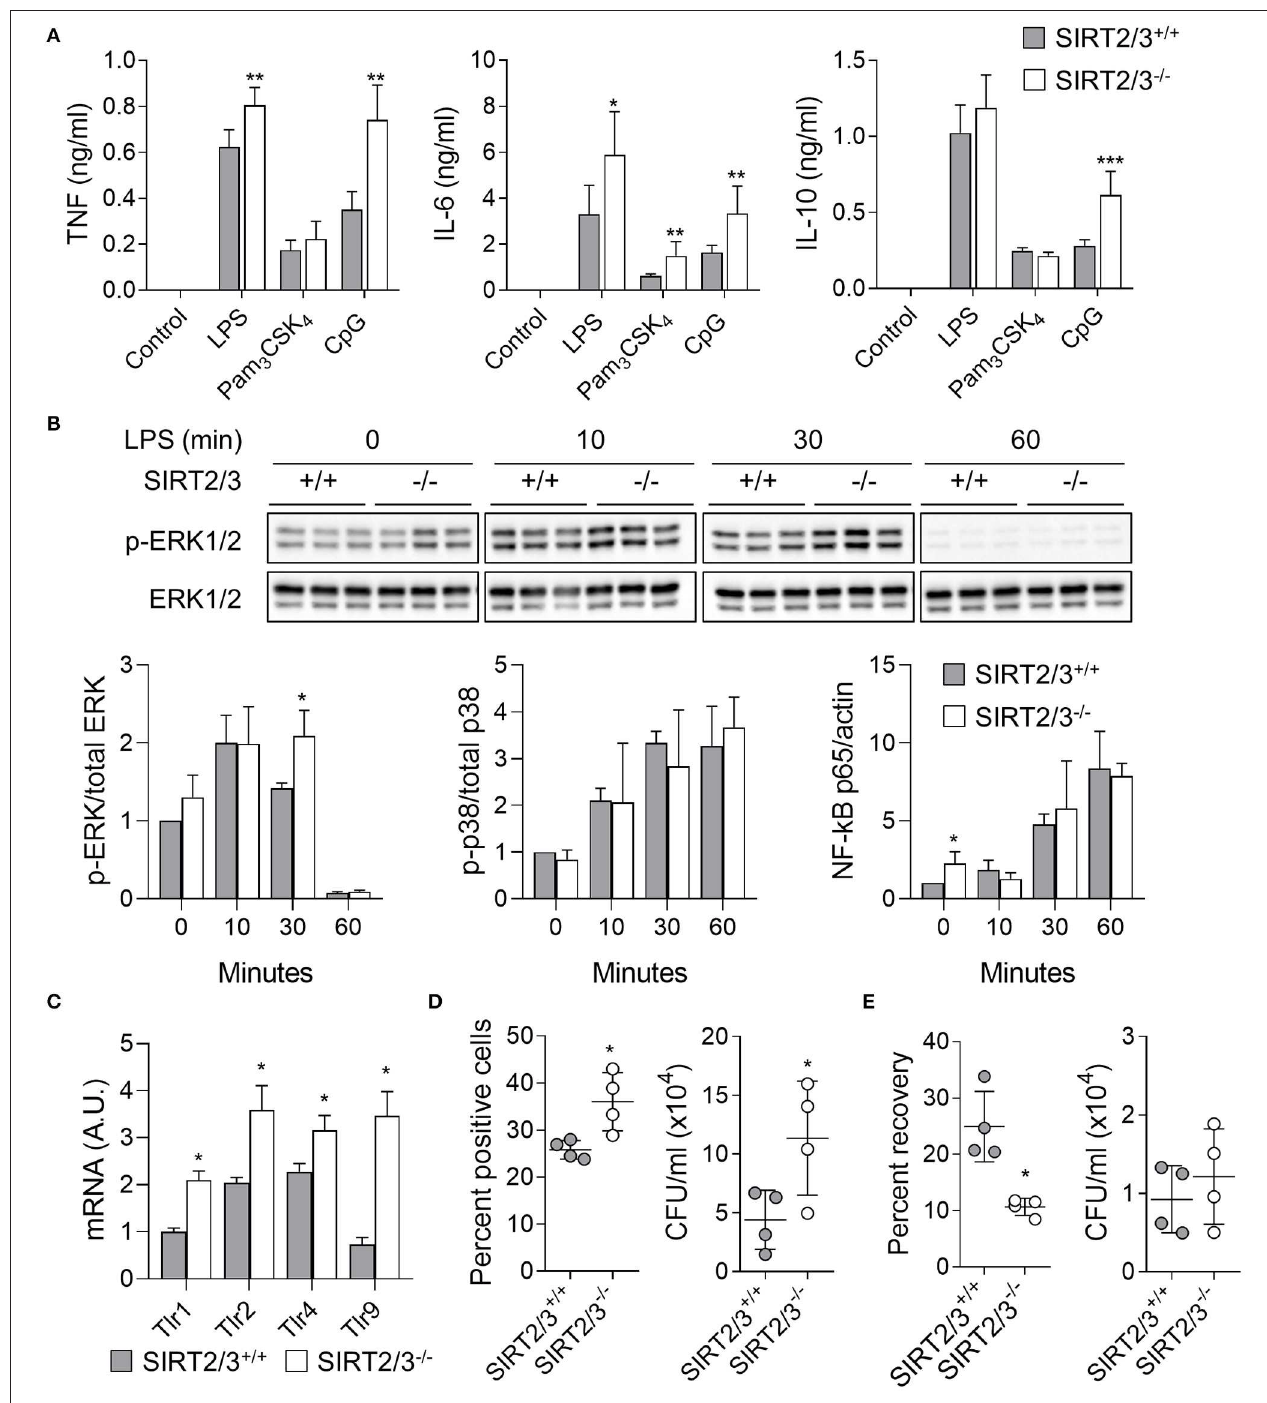
FIGURE 3 | SIRT2/3 deficiency increases cytokine secretion, phagocytosis and killing by macrophages. (A) BMDMs were exposed to LPS (10ng/ml), Pam 3 CSK 4 (100ng/ml), and CpG (1 µ g/ml) for 24h. The concentrations of TNF, IL-6, and IL-10 in cell culture supernatants were measured by ELISA. (B) BMDMs were exposed for 0, 10, 30, and 60min to 10ng/ml LPS. Phosphorylation of ERK1/2 and p38, and nuclear translocation of NF- κ B p65 were measured by Western blotting. Representative blots are presented for ERK1/2 phosphorylation (Full blots are available in Supplementary Figure 1 ). Quantitative data are means ± SD of three mice. (C) Tlr1, Tlr2, Tlr4, and Tlr9 mRNA levels in BMDMs were quantified by RT-qPCR and normalized to actin mRNA levels. Data are mean ± SD of four mice analyzed in triplicate. (D) Phagocytosis by BMDMs exposed for 1h to fluorescent beads (left) and live E. coli (right) at a bead or bacteria-to-cell ratio of 10:1. Data were analyzed by flow cytometry and colony enumeration, respectively. (E) Killing of E. coli by BMDMs. The percentage of recovery (left) was calculated by dividing the number of bacteria recovered after 6h by the number of bacteria recovered after 1h. Absolute counts are presented on the right. Data are mean ± SD of four mice analyzed in triplicate. Each dot represents a mouse. * P < 0.05; ** P < 0.01; *** P < 0.005.